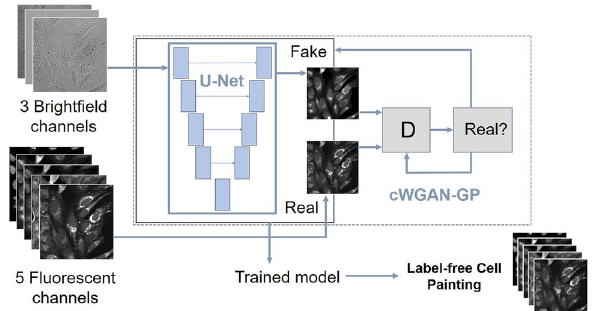
Figure 1. Summary of the models: U-Net trained on L1 loss and